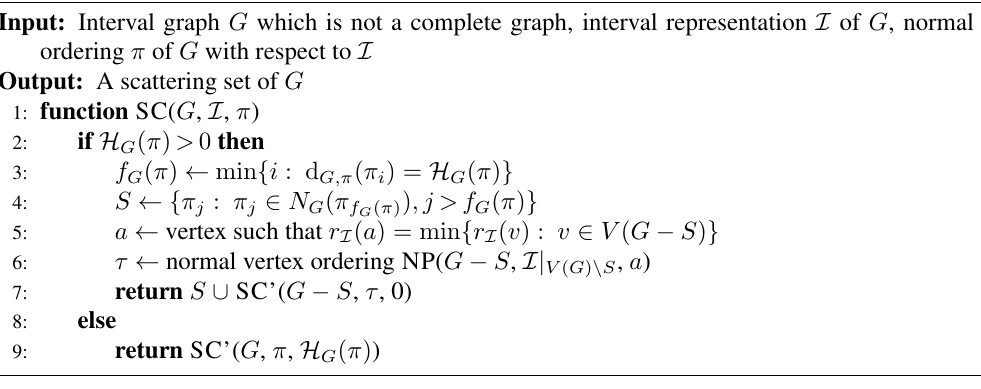
Algorithm 3.2 A scattering set of an interval graph